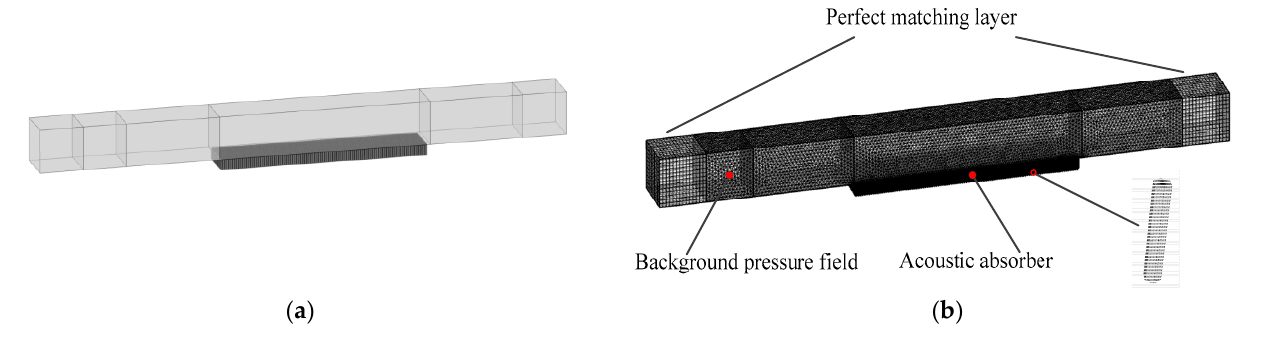
Figure 11. Structure in Reference [15] (suitable for the FNSE method). ( a ) Geometric model and ( b ) FE model.